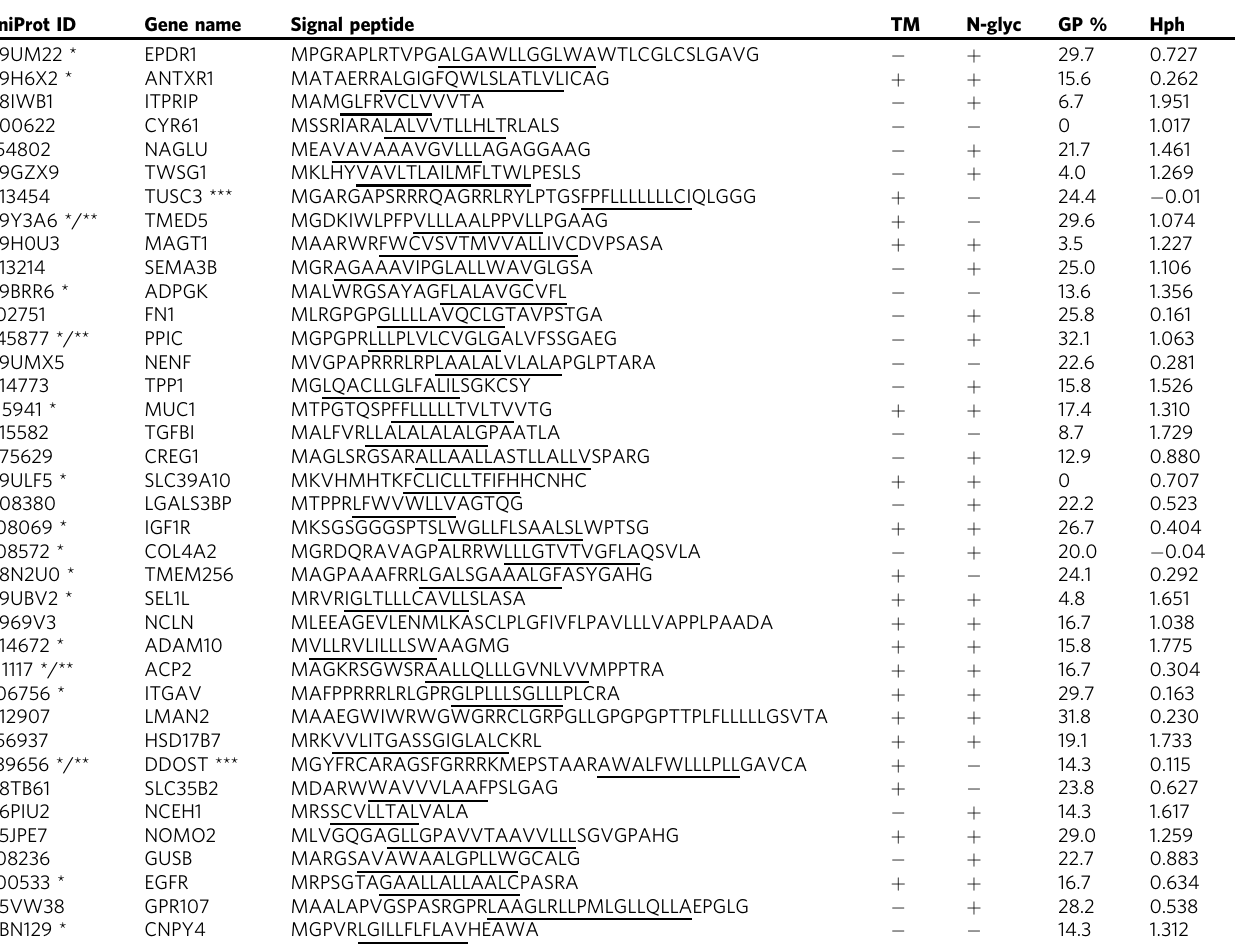
Table 1 Primary structures of signal peptides of putative TRAP clients UniProt